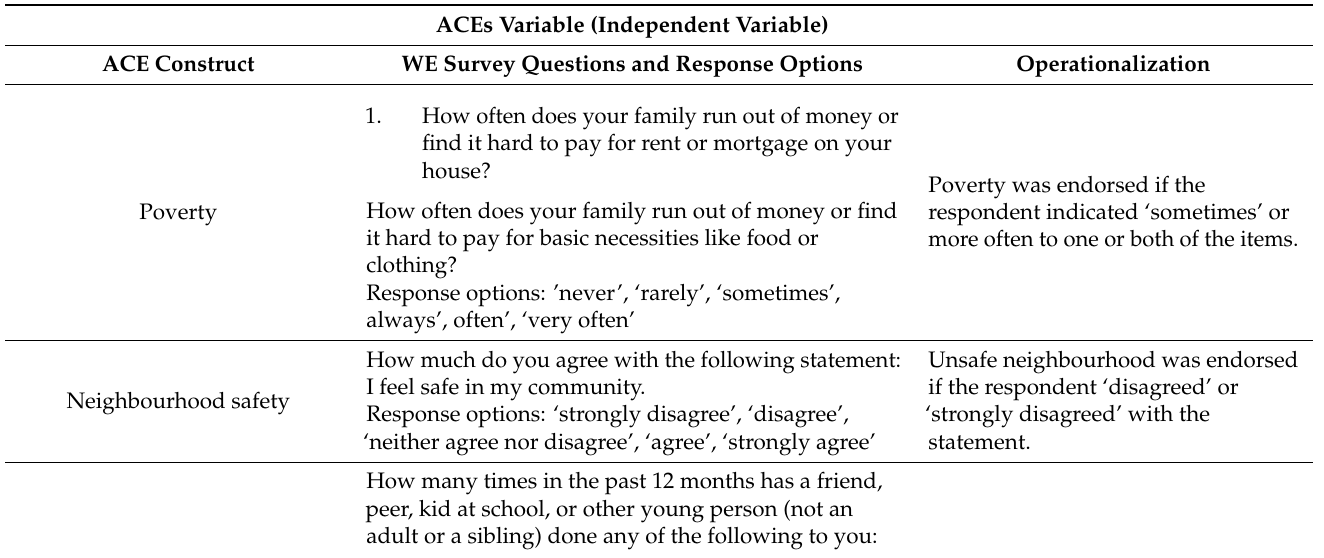
Table A1. Cont. ACEs Variable (Independent